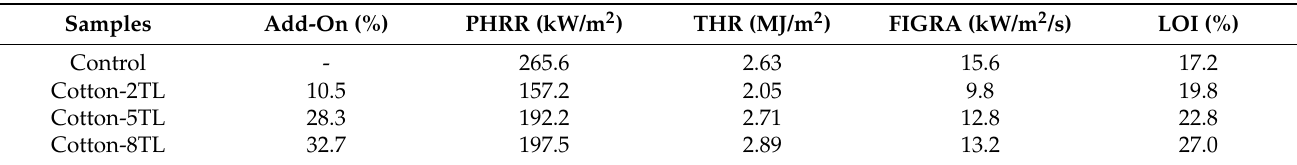
Figure 3. ( a ) TGA and ( b ) DTG curves of the control and FR cotton fabrics. Table 2. The related CCT data and LOI values for all